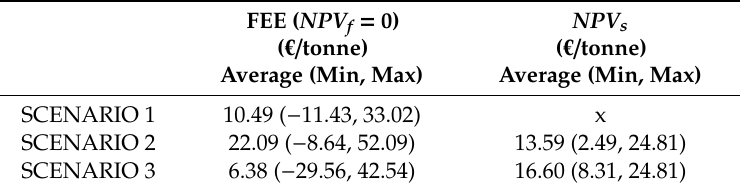
Table 2. Fee and social net present value ( NPV s ) resulting from Monte Carlo